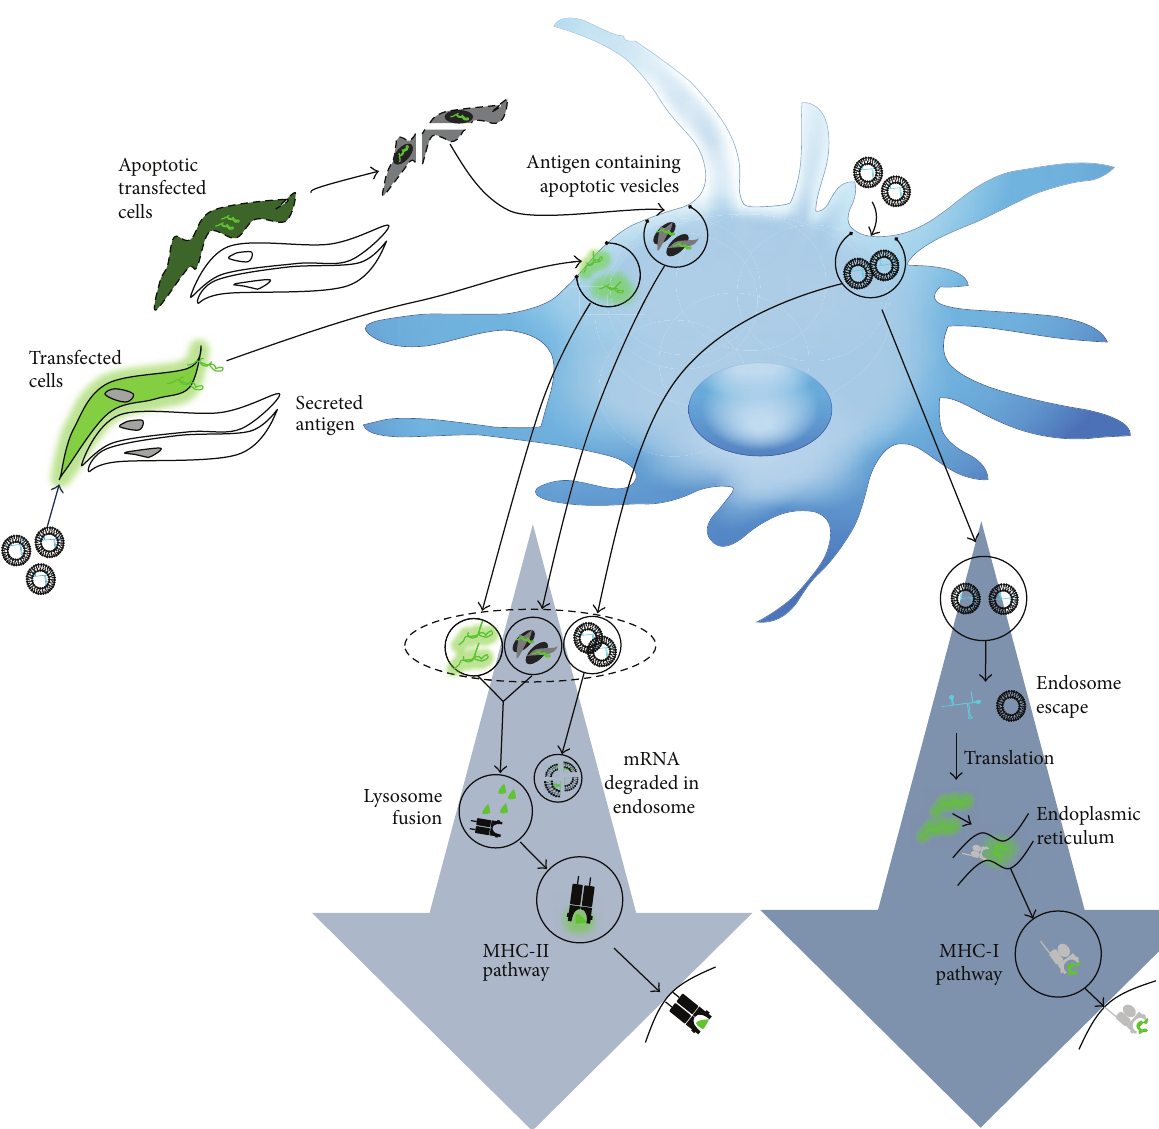
Figure 2: The genetic vaccination model. Antigen presentation occurs directly by transfected DCs through gene expression of the antigen. DCs also cross present antigens secreted by transfected bystander cells, or derived from phagocytosis of apoptotic cells. Cross presentation mechanisms in DCs may facilitate delayed lysosomal delivery leading to higher delivery